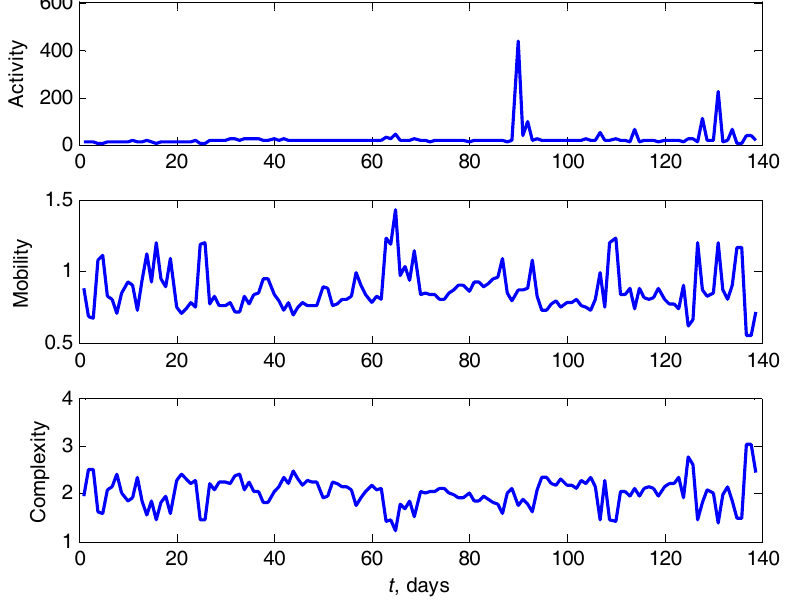
Figure 6. Hjorts’ features calculated from the vibration slew bearing signal.